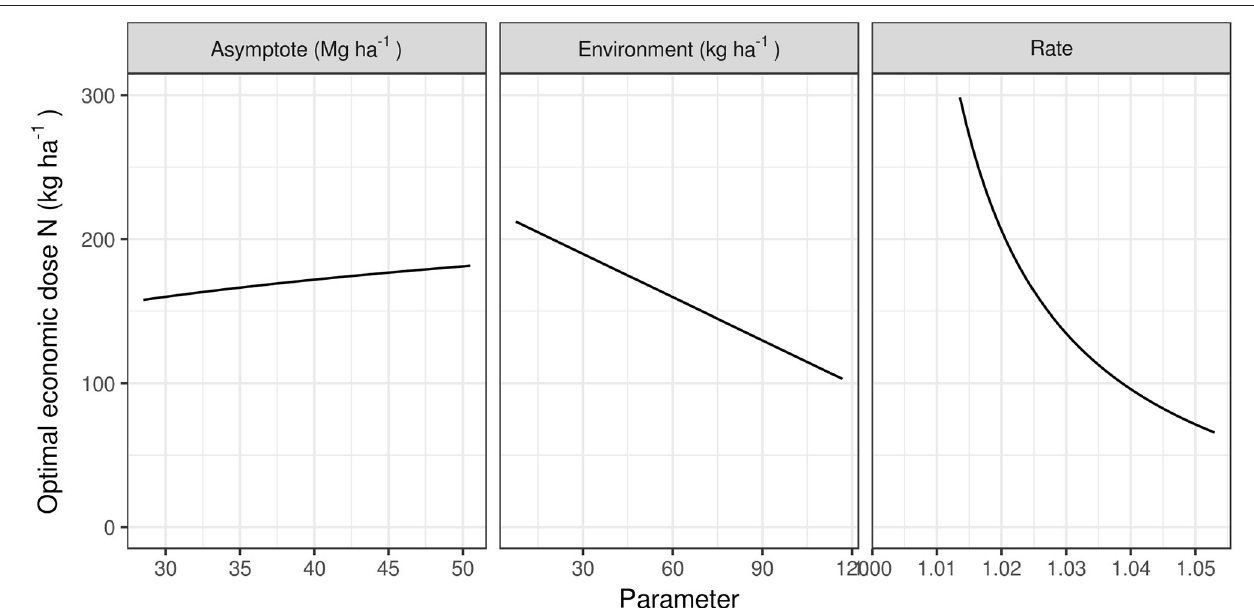
FIGURE 9 | Sensibility analyses conducted on Mitscherlich parameters defined in Equation